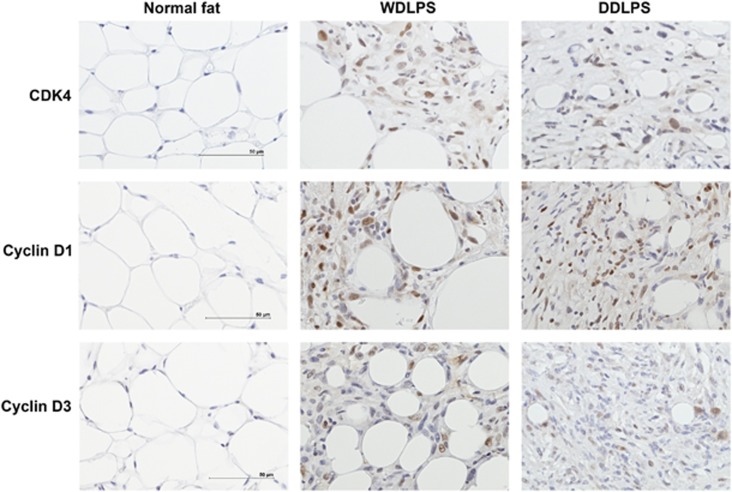
Immunohistochemical analysis of cell cycle markers in WDLPS and DDLPS subtypes. There is a deregulation in the G1–S checkpoint with the upregulation of CDK4, Cyclin D1 and Cyclin D3. Scale bar corresponds to 50 μm